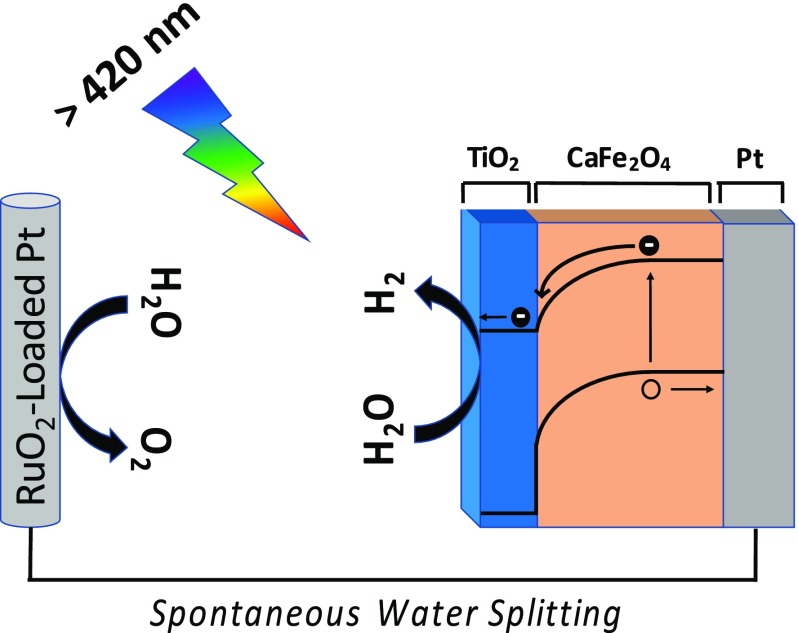
 Schematic of a photoelectrochemical cell consisting of TiO2-coated/CaFe2O4 in series with RuO2-Loaded Pt. This cell split water spontaneously without an applied bias under visible light illumination. The cell was designed and optimized using wxAMPS simulations.